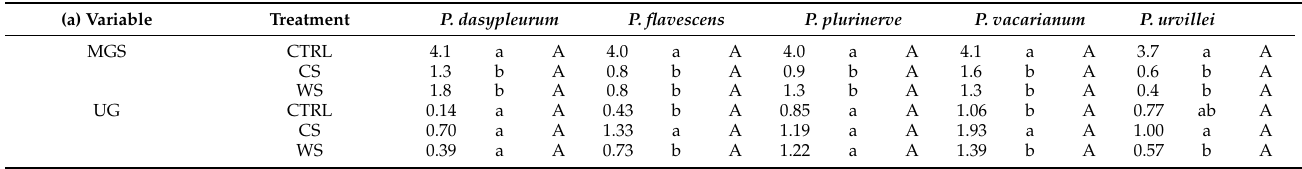
Table A4. Adjusted means for mean germination time (MGT), mean germination section (MGS) and uncertainty of germination (UG) for each level of treatment and species within each experiment. ( a ) Experiment one, stratification treatments: seed without stratification (CRTL), cold stratification (CS), and warm stratification (WS). ( b ) Experiment two, alternating temperatures and nitrate addi- tion. Results from 10/20 ◦ C from Experiment two were omitted because several species showed nil